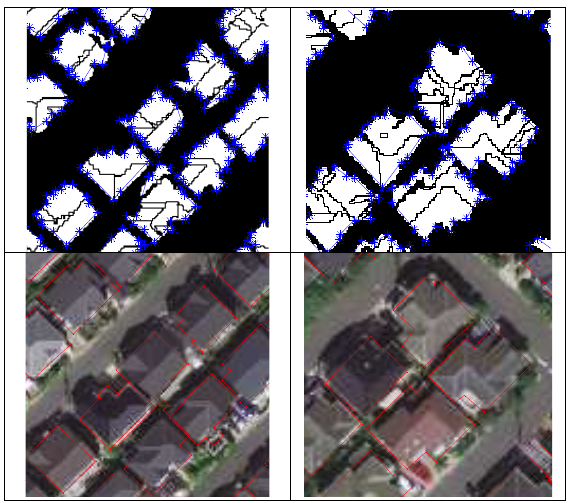
Figure 7 Corner and model details